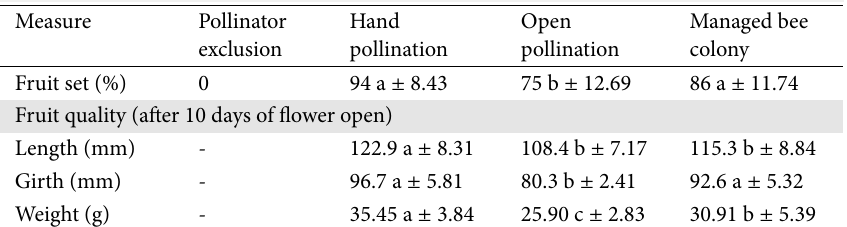
Table 3 Effect of pollination treatments on field-grown bitter gourd.